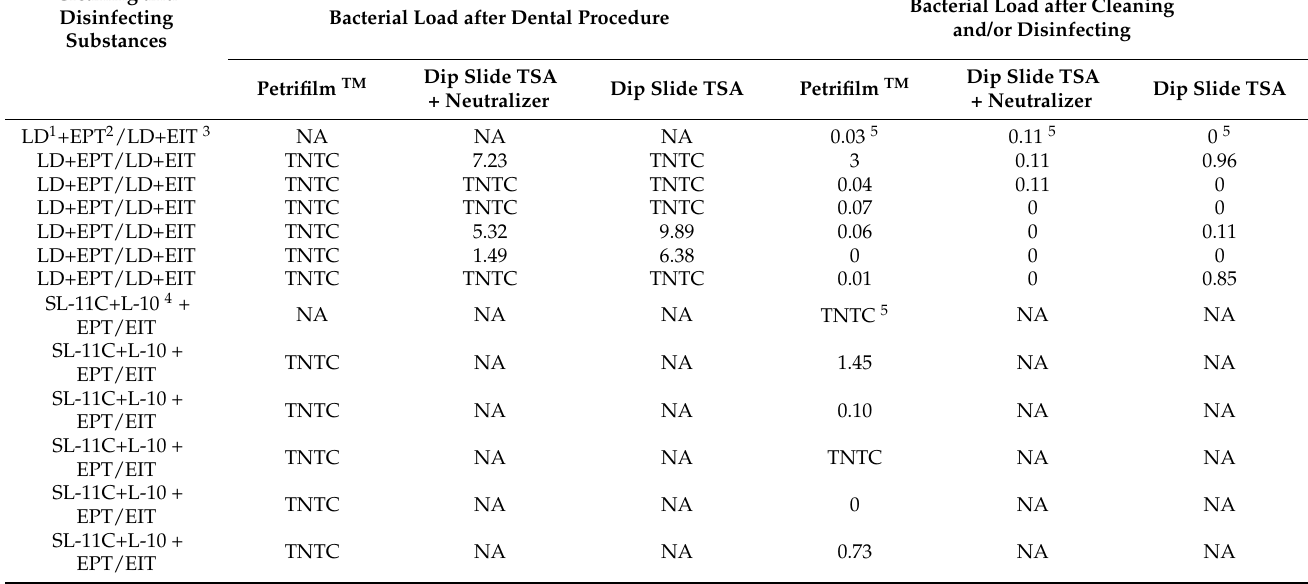
Table 6. Bacterial load detected on the head support after dental procedures, and after cleaning and/or disinfecting. Colony forming units (CFU) are given in CFU/cm 2 . For bacteriological analyses 3M Petrifilm TM aerobic count (AC) Plates and dip slides with TSA agar/TSA agar with a neutralizer, neutralizing several disinfectants. Cleaning and